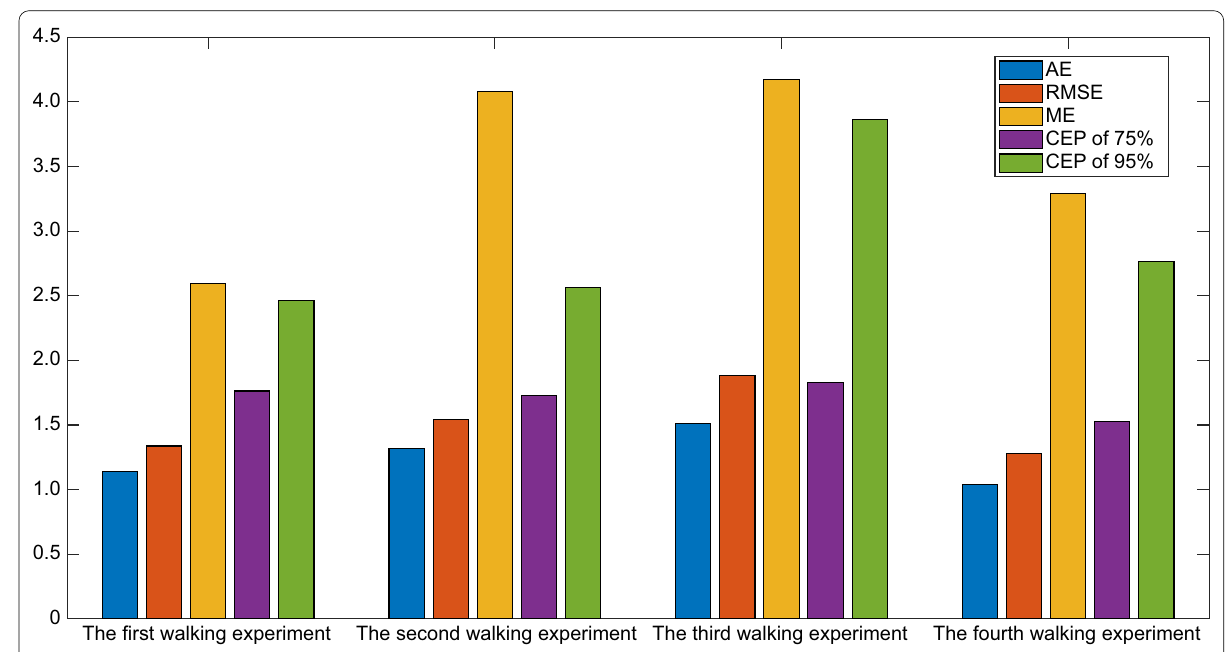
Fig. 22 Position errors of four walking experiments